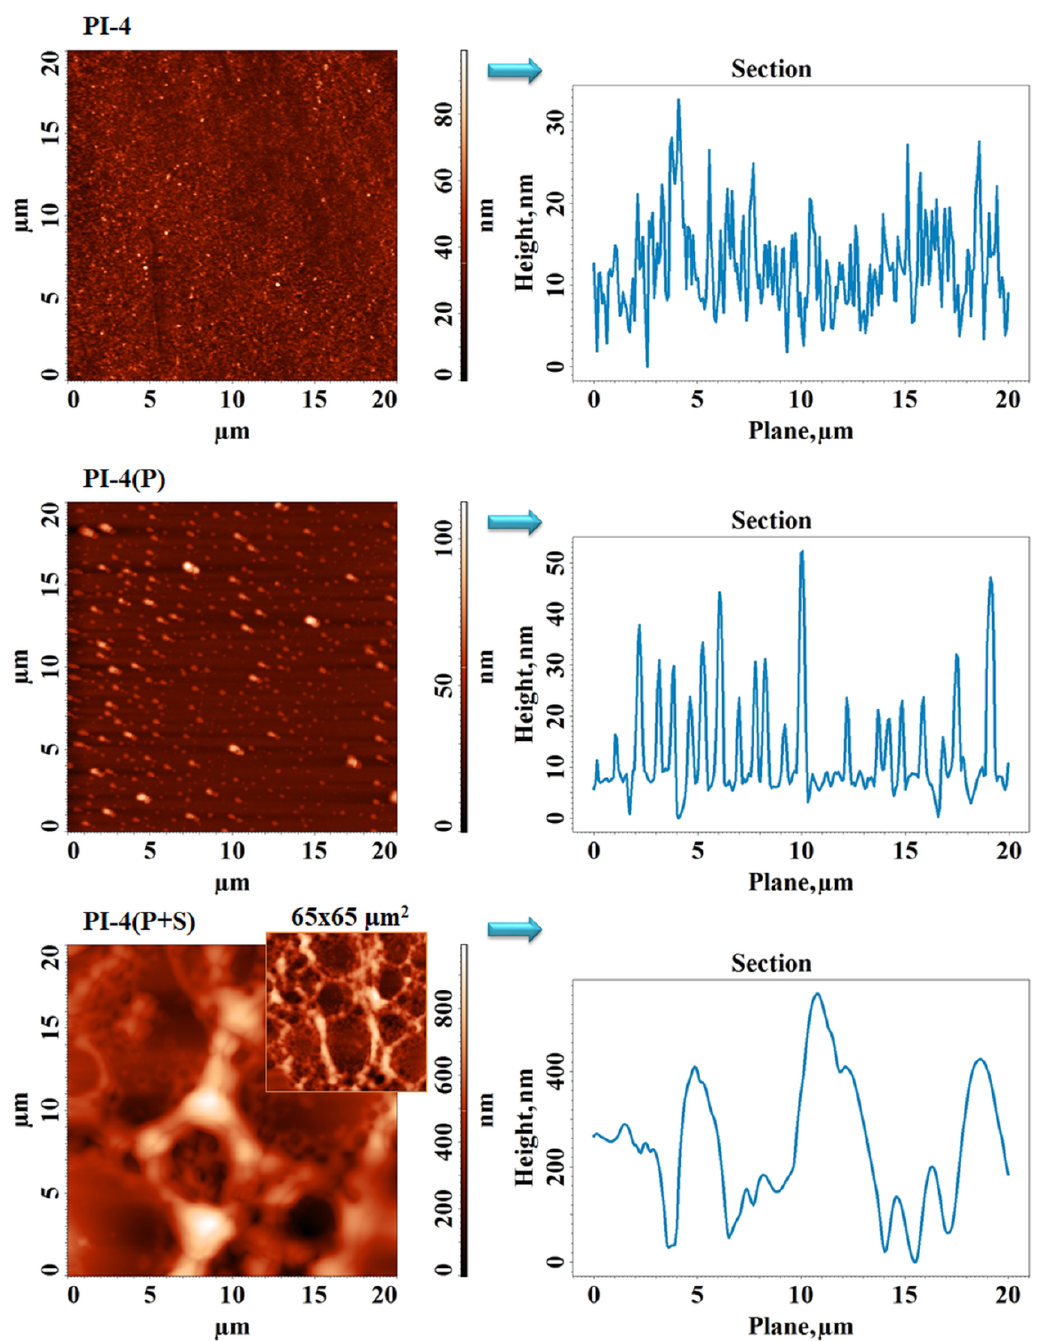
Figure 9. The AFM images and corresponding average cross-section profiles collected for the sample PI-4 before and after DCSBD plasma treatment (P) and DCSBD plasma treatment followed by spraying (P+S).